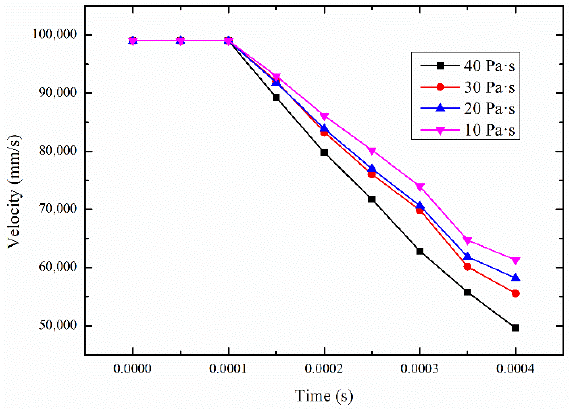
Figure 11. Speed changes rate in different